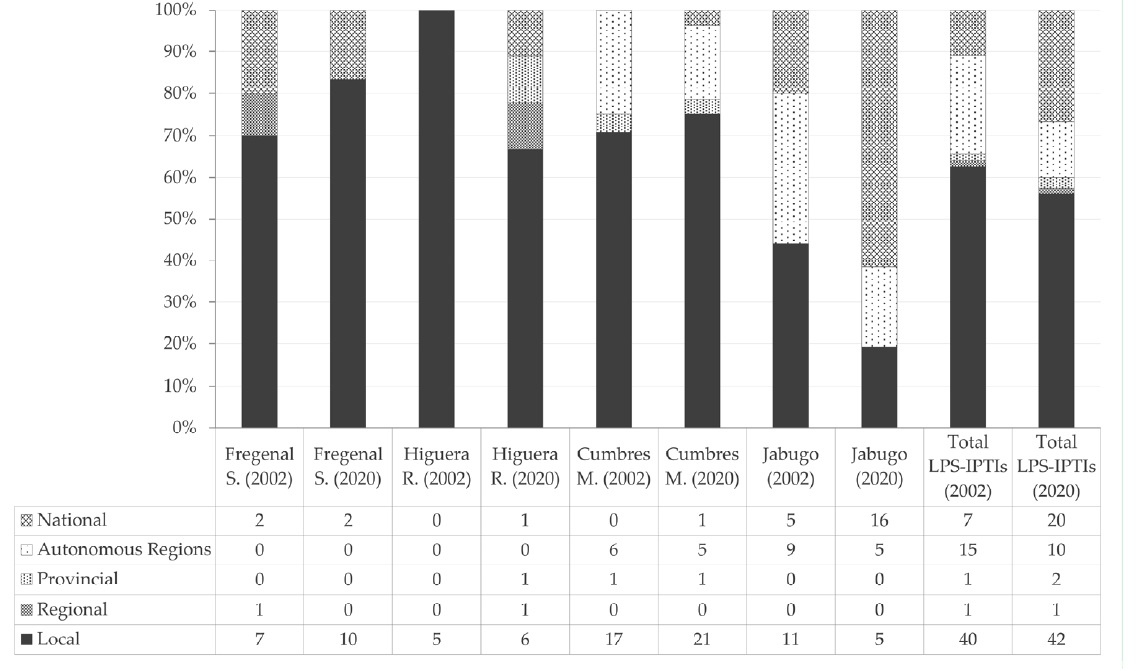
Figure 8. Company headquarters (2002 and 2020). Source: [80,81,94,95]. Authors own elaboration.